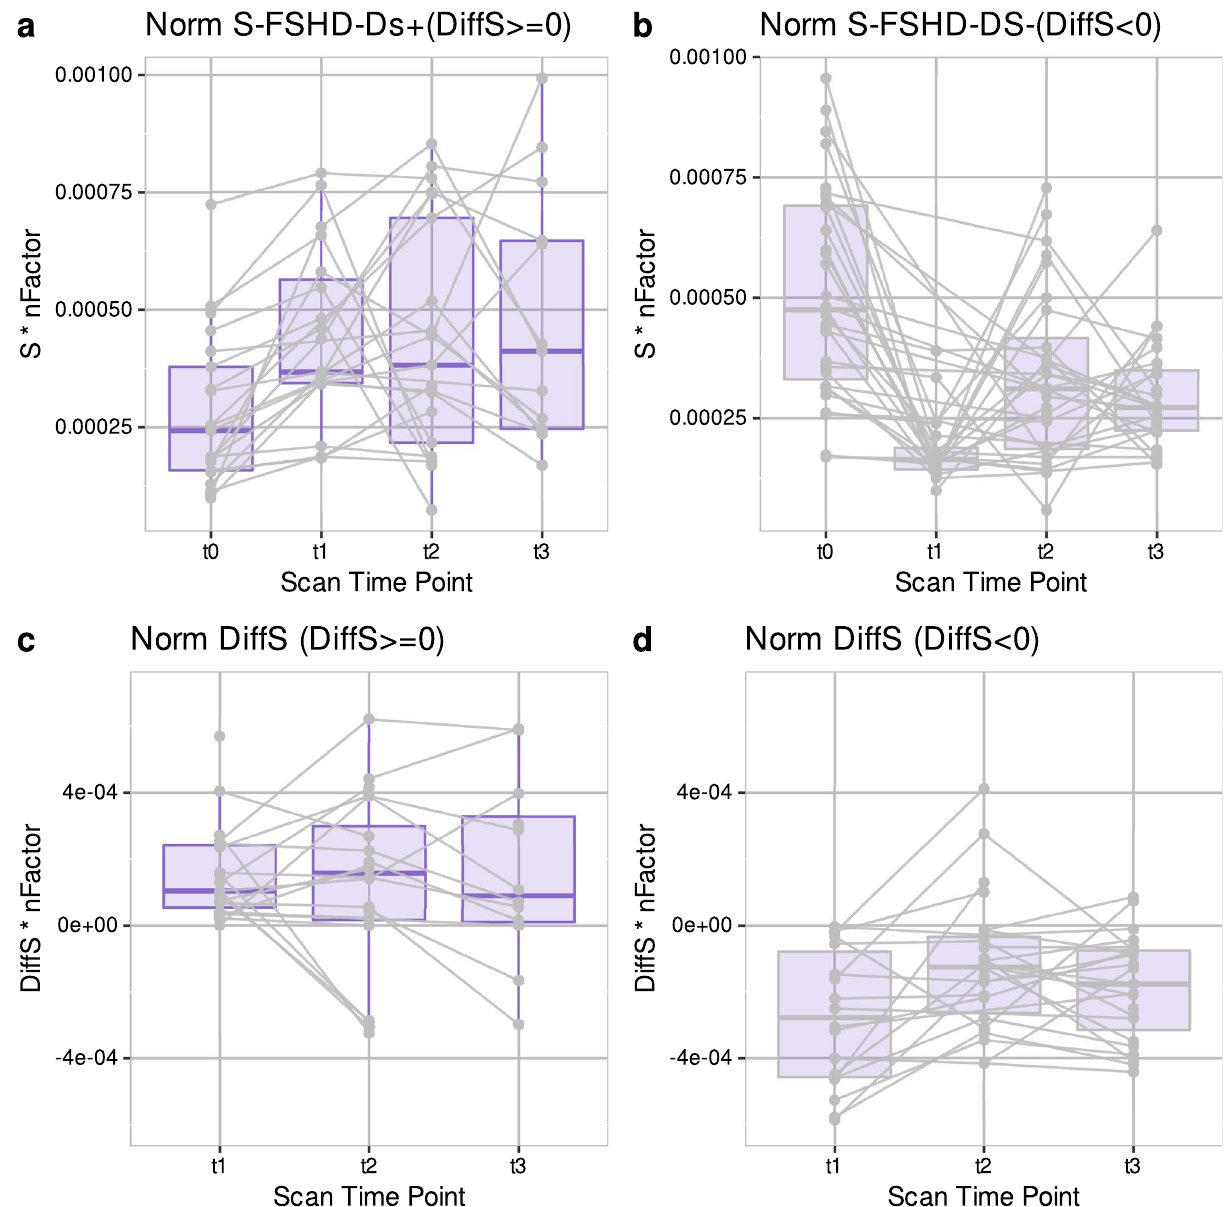
Figure 4. Datasets for FSHD patients, including a minimum of three time points (any combination out of the 4 time points t0, t1, t2, t3). ( a ) Strain for the FSHD-Δs+ datasets (number of datasets:21 (t0), 19 (t1), 21 (t2), 13 (t3))). ( b ) Strain for the FSHD-Δs− datasets (31(t0), 20 (t1), 28 (t2), 25 (t3)) (see Fig. 3). ( c,d ) Respective differences in the strain from t0 (DiffS). For the FSHD-Δs+ group, the median difference from the baseline remains stable (with an increasing variability). For the FSHD-Δs− group, there are larger fluctuations in the difference from the baseline and the absolute difference is larger between the first 2 time points than in subsequent ones. FSHD-Δs+ /FSHD-Δs − : groups of the strain data of FSHD patients based on the changes between t0 and t1. Norm.: Values of strain normalized to the applied